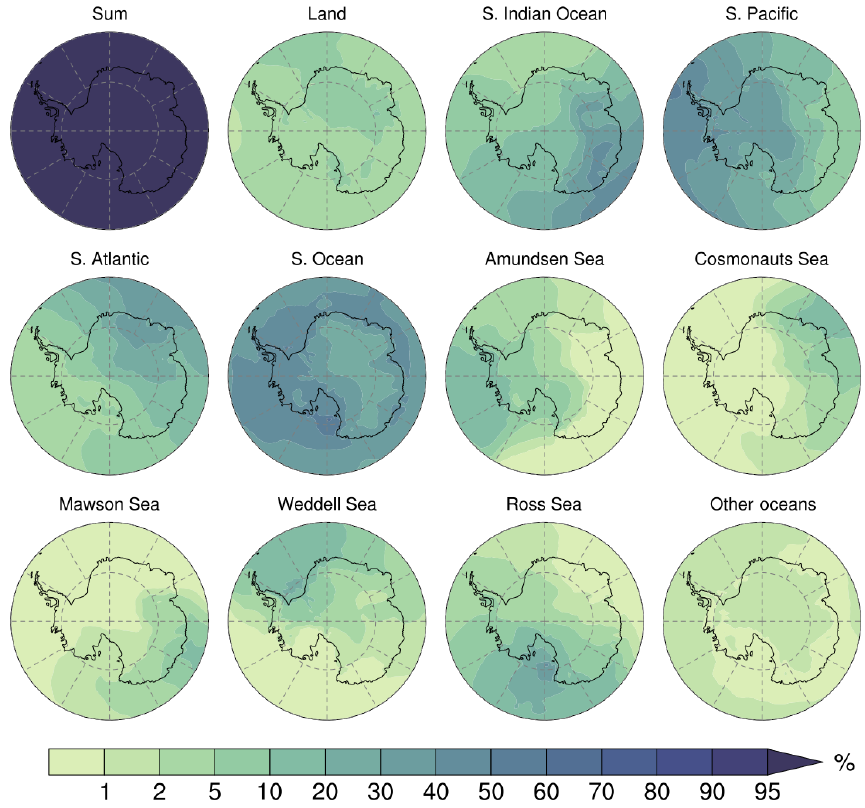
Figure 6. Spatial distribution of fractional contribution (%) to annual mean precipitation at the surface from individual source regions in the mean case. The “Sum” (upper-left panel) represents contributions from the five major source regions, including land, southern Indian Ocean, South Pacific, South Atlantic and Southern Ocean. Contributions from tropical oceans and Northern Hemisphere oceans are combined into “Other